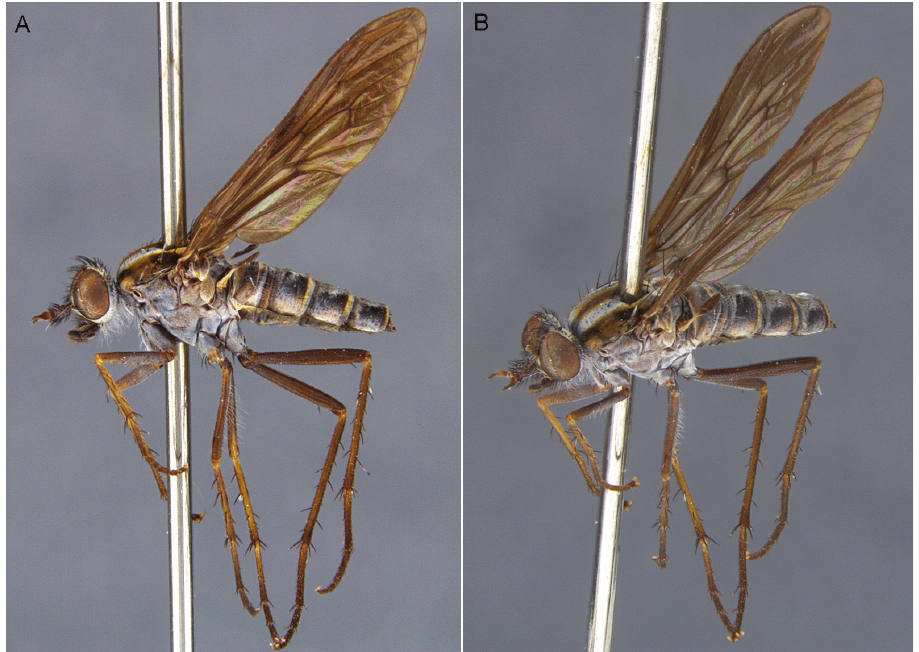
Figure 10. Sidarena geraldton sp. n.: A Male lateral view B same, oblique Sidarena geraldton sp. n. http://zoobank.org/B7AD7460-2384-4D24-B9C3-583D771E6219